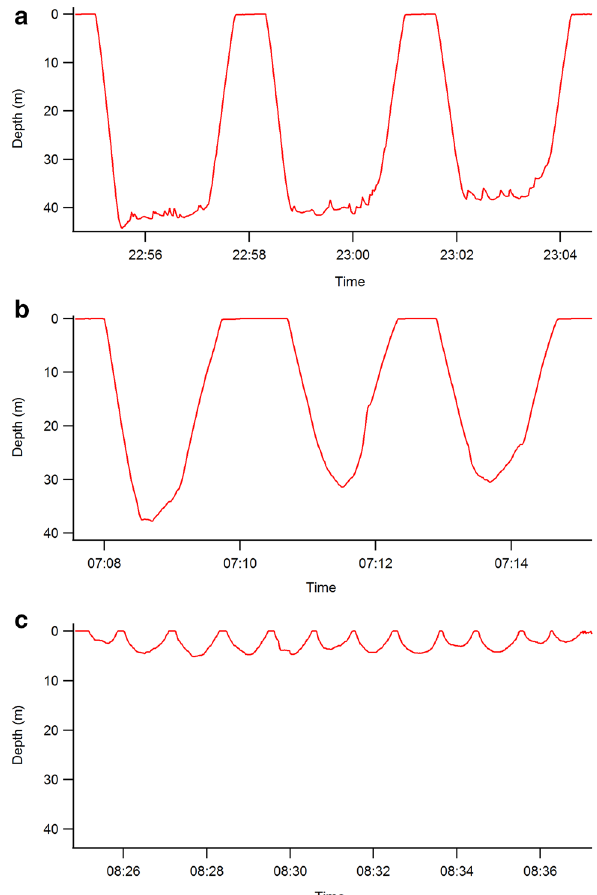
Figure 1. Adélie penguin dives were classified into ‘foraging’, ‘exploratory’ and ‘other’ 39 . ( a ) foraging dives were at least 10 m deep, had significant bottom time and many undulations (cases a–c in the methods); ( b ) exploratory dives were at least 10 m deep but had relatively little bottom time and/or few undulations (cases d, e in the methods); ( c ) other dives, thought to be primarily commuting dives, were shallower than 10 m and/or not matching the requirements for foraging and exploratory